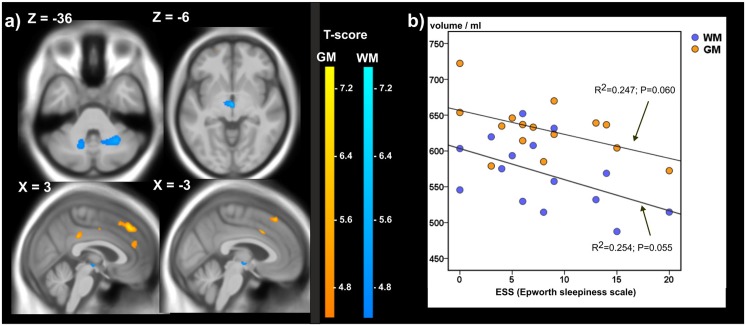
ESS and brain grey and white matter in DM2.a) Significant negative correlations between GM and WM and Epworth sleepiness score in 15 DM2 patients detected by voxelwise multiple regression analysis. Age was used as a covariate of no interest. Clusters with FWE corrected cluster p-values < 0.07 are depicted; MNI coordinates: negative X-values reflect left side and positive X-values right sided location. b) Scatterplot of global brain GM and WM in dependency on ESS; the lines and annotations reflect the results of the linear regression analysis.